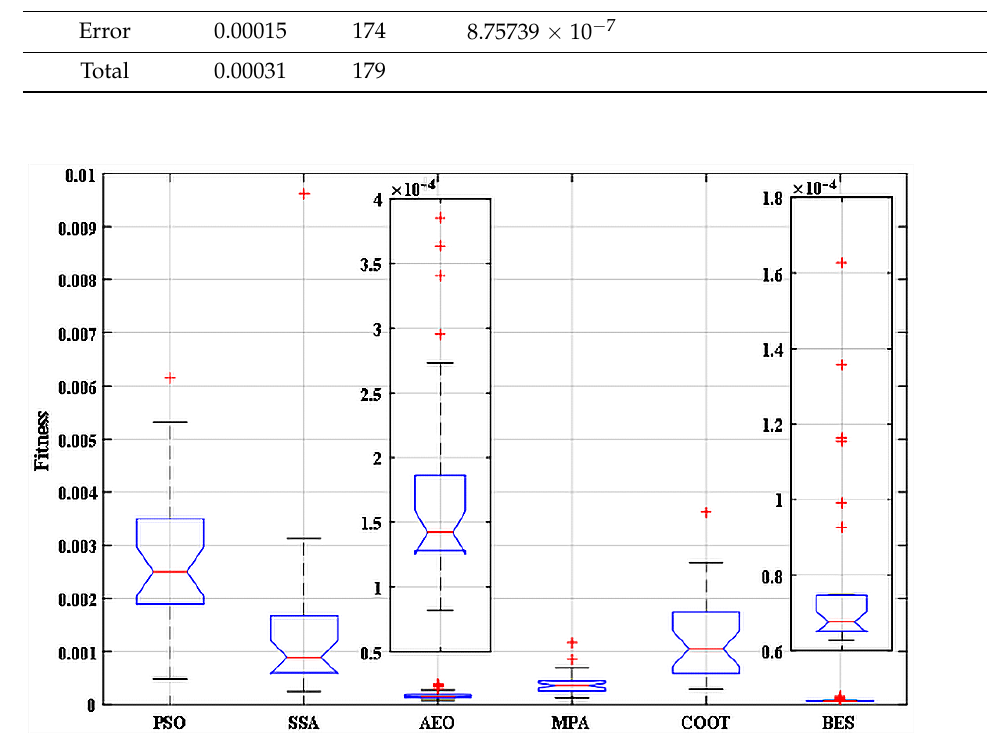
Figure 6. ANOVA ranking for the considered algorithms. The calculated and measured voltages are given in Figure 7. The model output voltage is identical to the measured battery voltage. Therefore, the battery parameters were accurately identified using the proposed strategy.